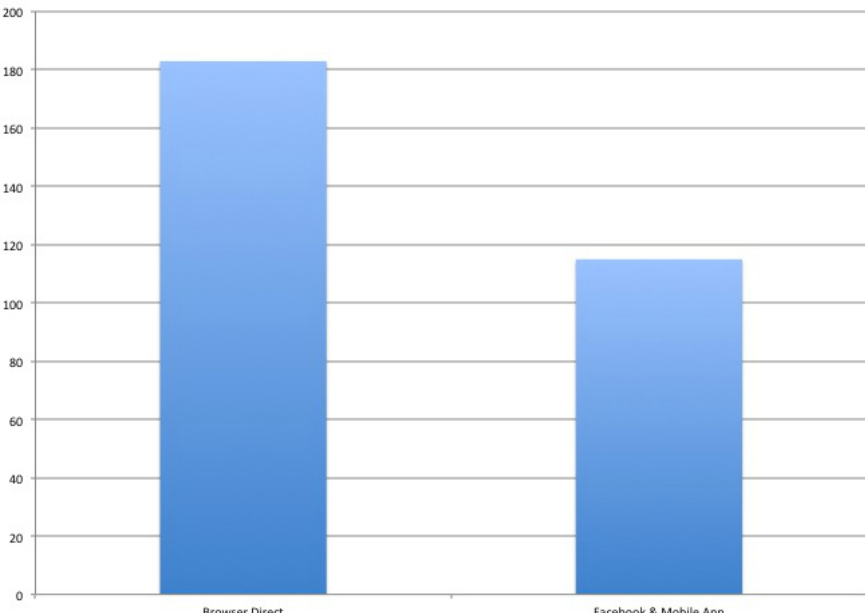
Figure 6. Comparison between direct Web-link access versus Facebook/smartphone access to Web-based